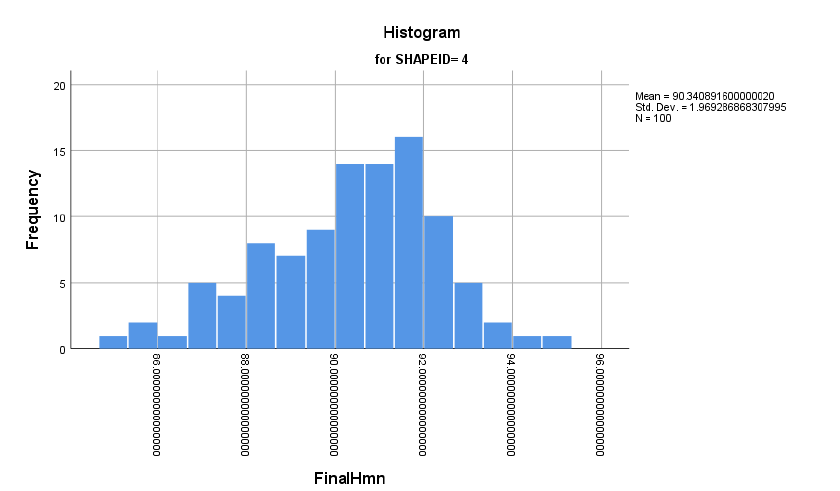
Figure A9. Shrink height adjustment for 90 mm.